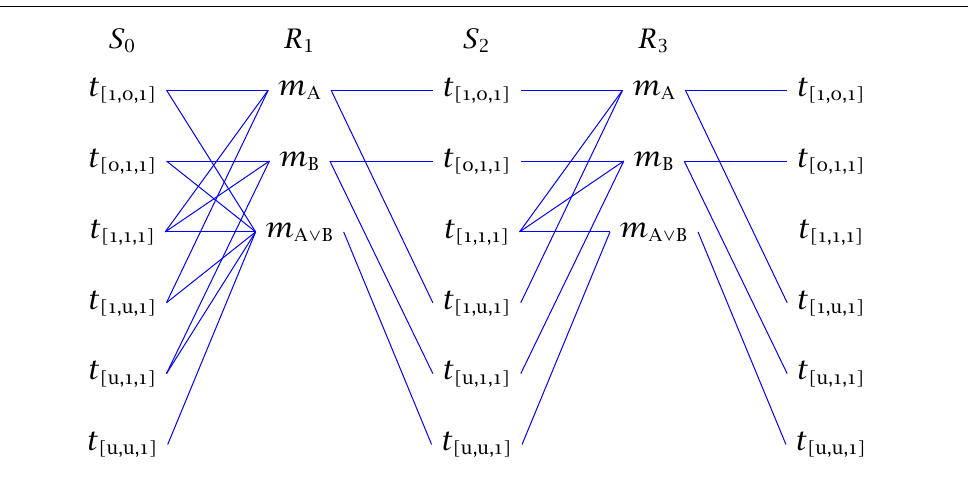
interpreted as either A